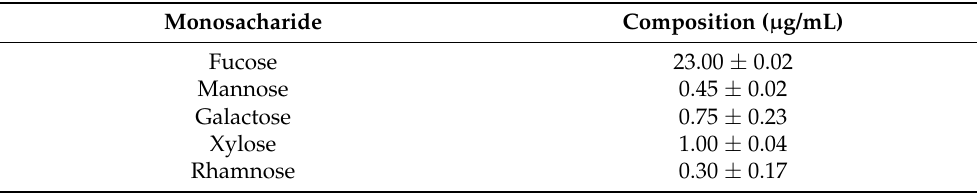
Table 4. Monosaccharides composition of fucose-containing sulphated polysaccharides in S. polycystum ( µ g/ mL).